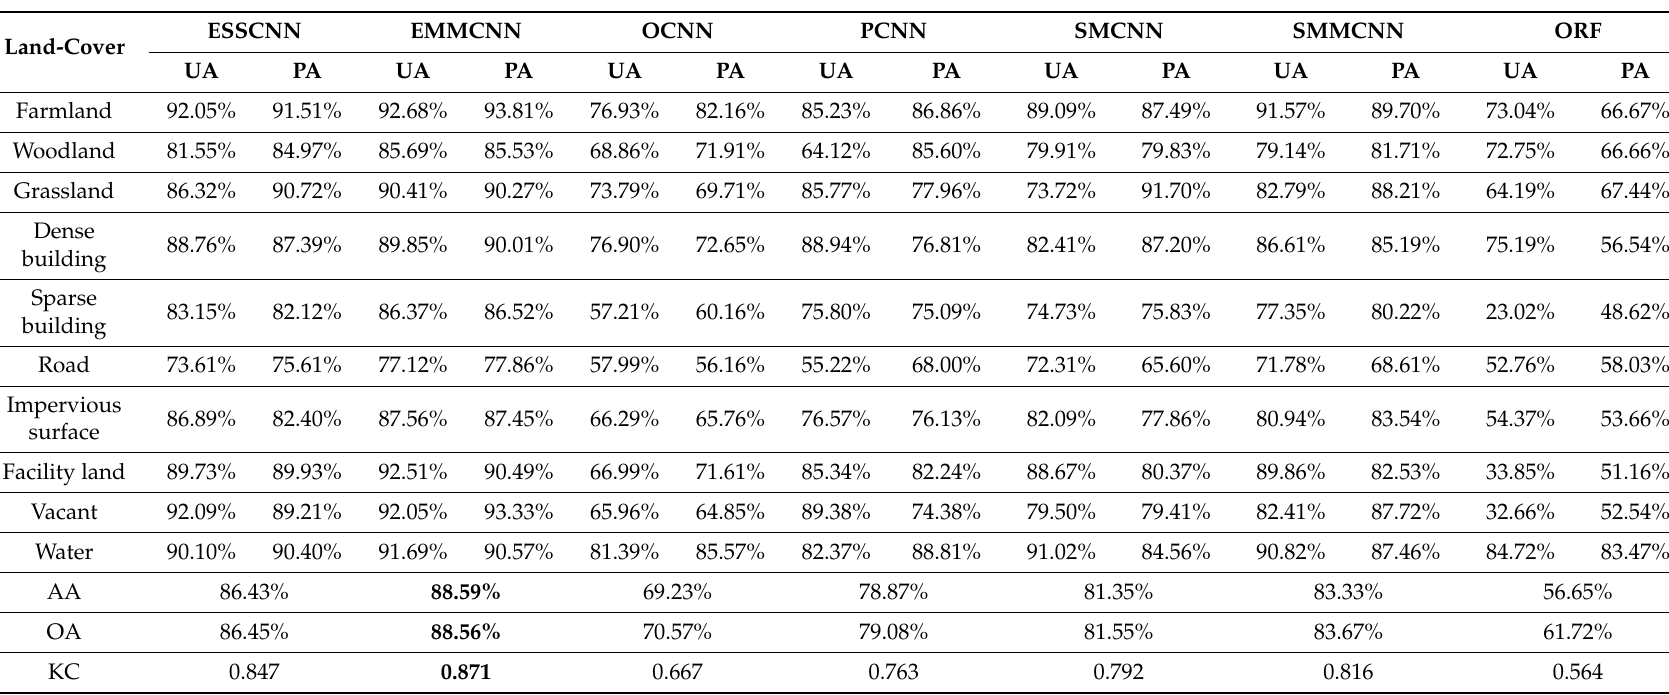
Table 8. Classification accuracy comparison amongst ESSCNN, EMMCNN, OCNN, PCNN, SMCNN, SMMCNN, and ORF methods for the Beilun dataset.